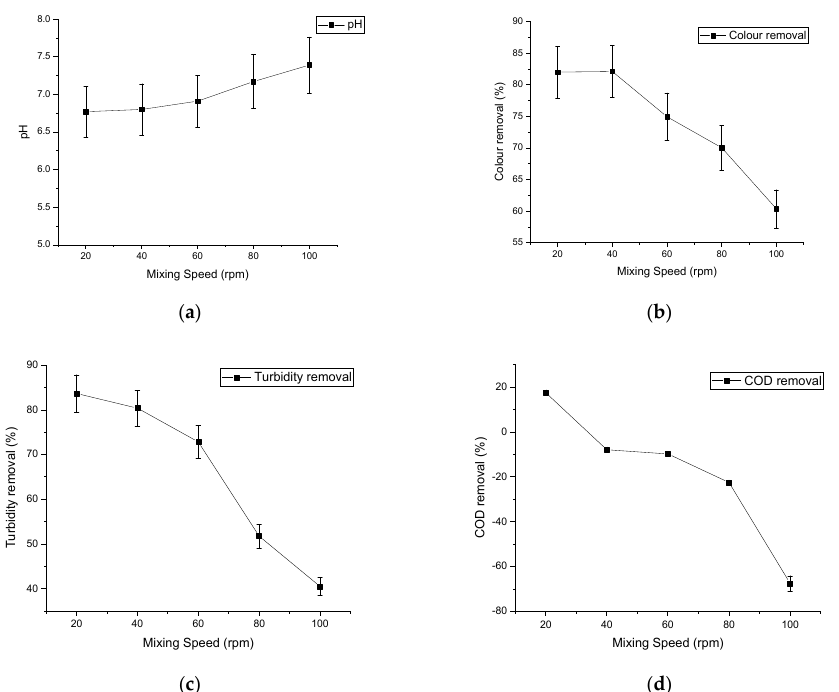
Figure 3. Trends of the effect of mixing speed on photocatalysis treatment parameters: ( a ) The effect of mixing speed on pH; ( b ) The effect of mixing speed on colour removal; ( c ) The effect of mixing speed on turbidity removal ( d ) The effect of mixing speed on COD removal (reaction time of 30 min and catalyst loading of 0.9 g/L).